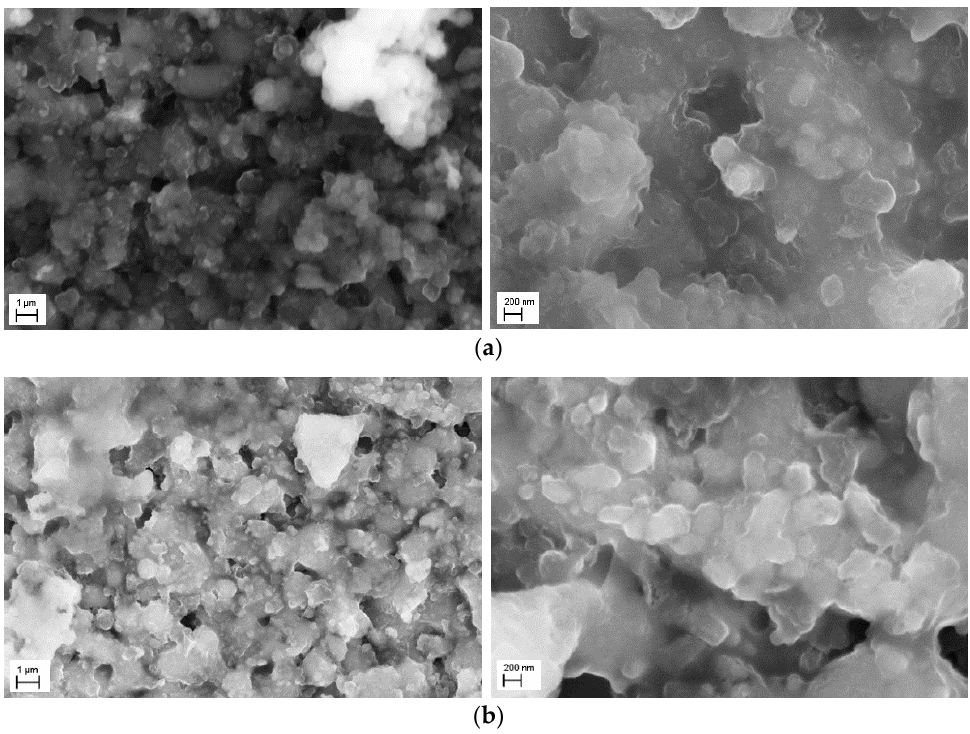
Figure 3. SEM images of the Li 3 V 2 (PO 4 ) 3 (86 wt%)/Li 3 PO 4 (14 wt%) composite surfaces after 200 charge/discharge cycles at different magnifications.